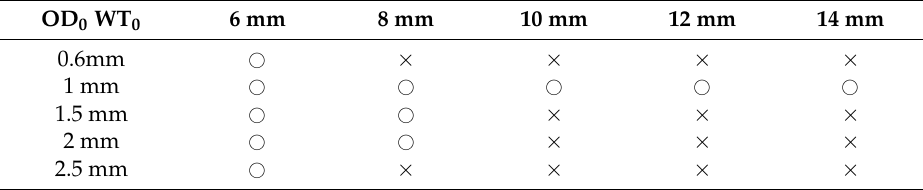
Table 1. Sizes of 1Cr18Ni9Ti tube samples selected in experiment.